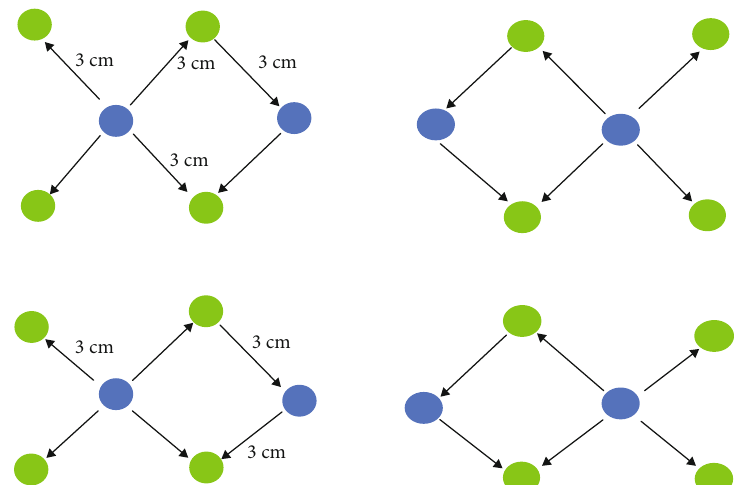
Figure 1: Con fi guration of laser sources and optical detector pair: 24 channels were generated to cover both the Broca and Wernicke areas and respective contralateral sides.